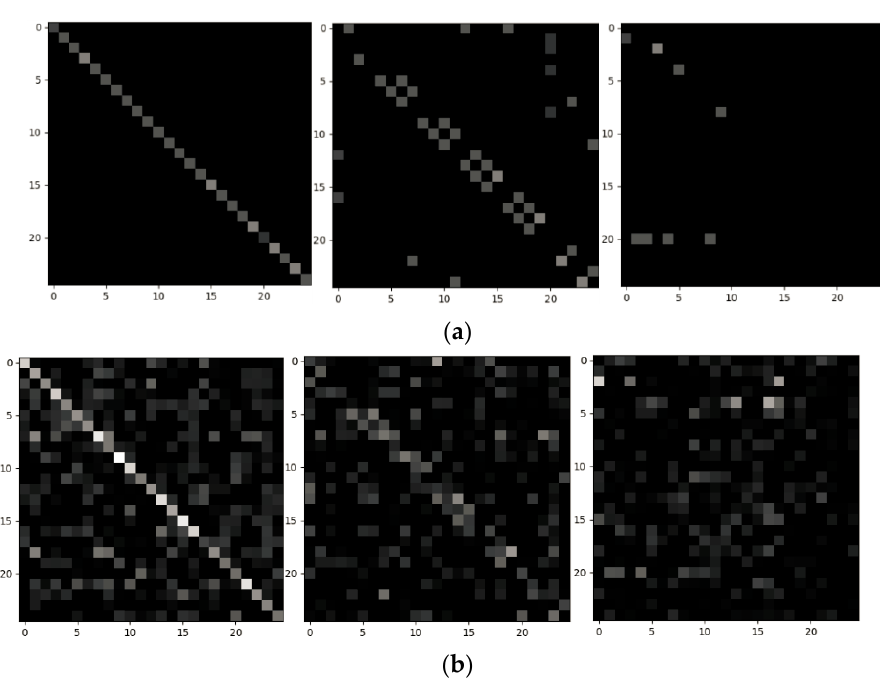
Figure 8. Visualization of the adjacent matrix of each subset in the Kinetics dataset. ( a ) The original adjacent matrix em- ployed in ST-GCN [20]. ( b ) The adaptive adjacency matrix learned by our model.